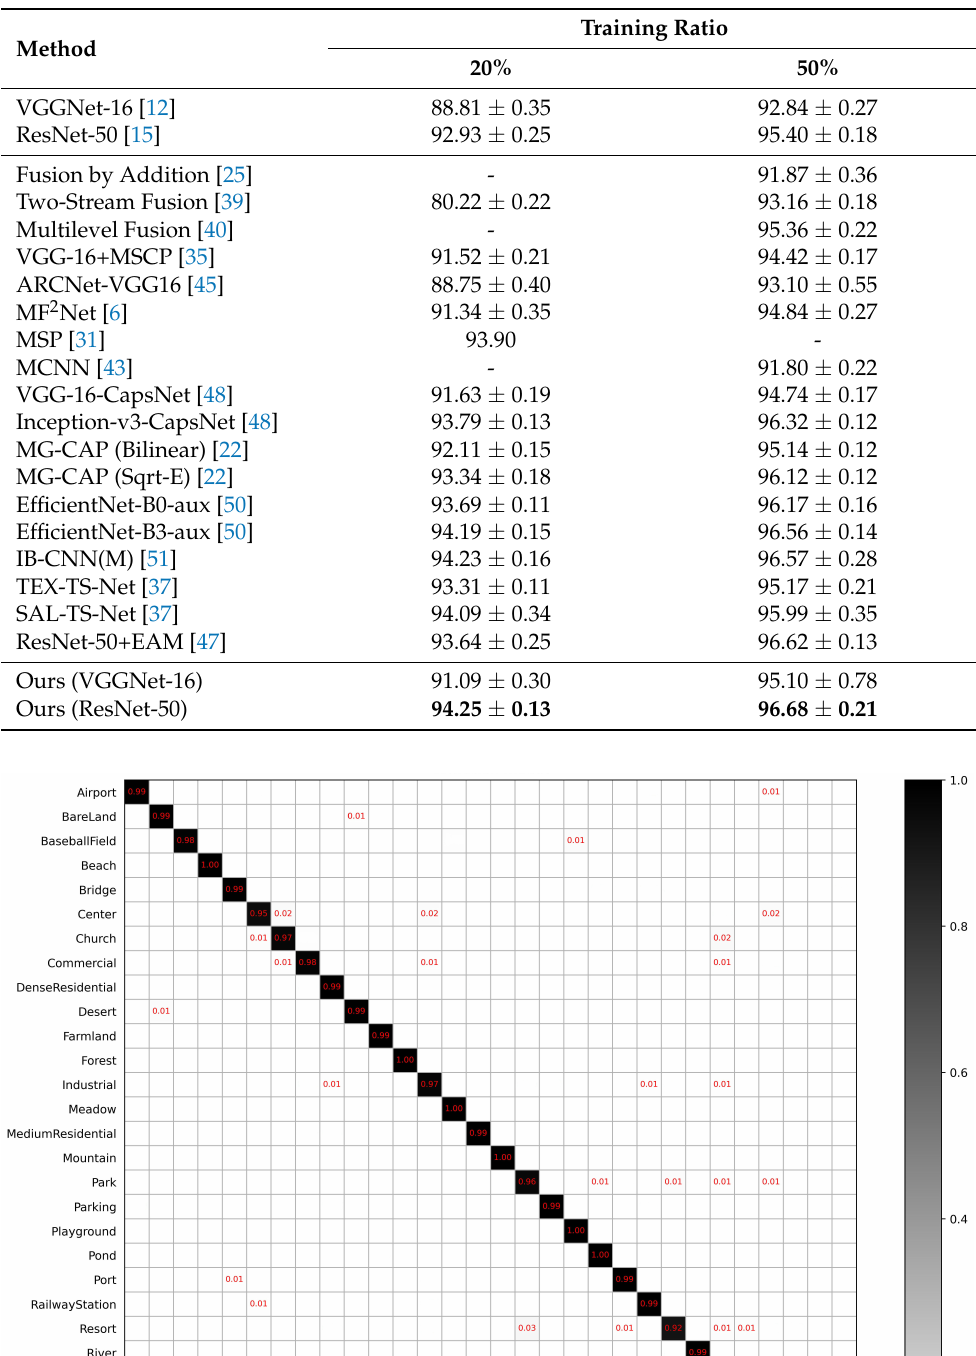
Table 3. Overall accuracy and standard deviation (%) of different methods on the AID dataset.